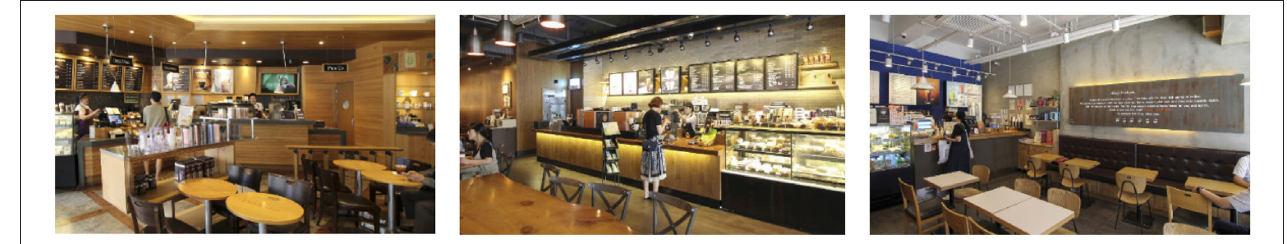
FIGURE 1 | Visual stimuli for eye-tracking experiments—photos of three coffee shops, from left, I-1, I-2, and I-3 (Kwon and Kim, 2018, p. 82; 2020, p. 447).